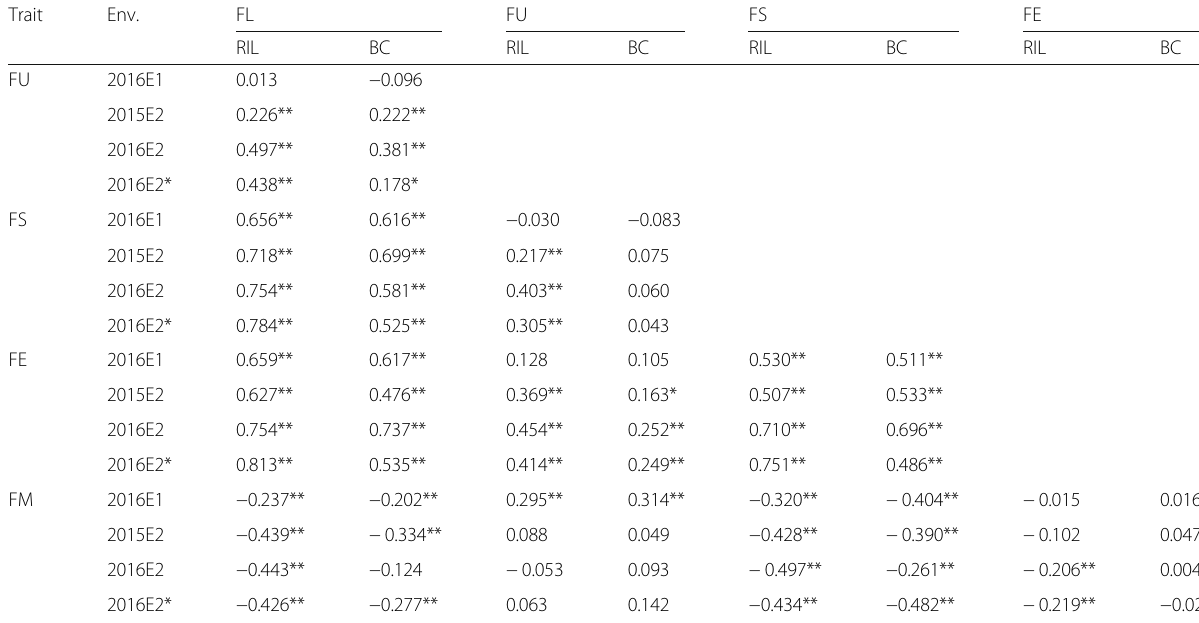
Table 3 Correlation analyses between five fiber quality traits in RIL population and its BC progenies Trait